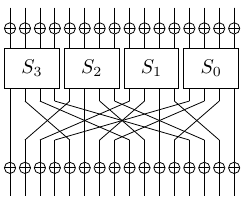
Figure 6: 1 round of SMALLPRESENT-[4]